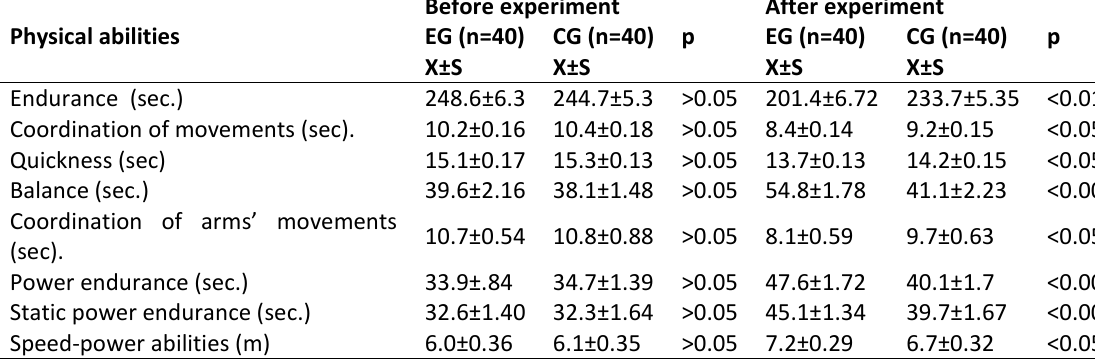
р EG (n=40) CG (n=40) EG (n=40) CG (n=40)